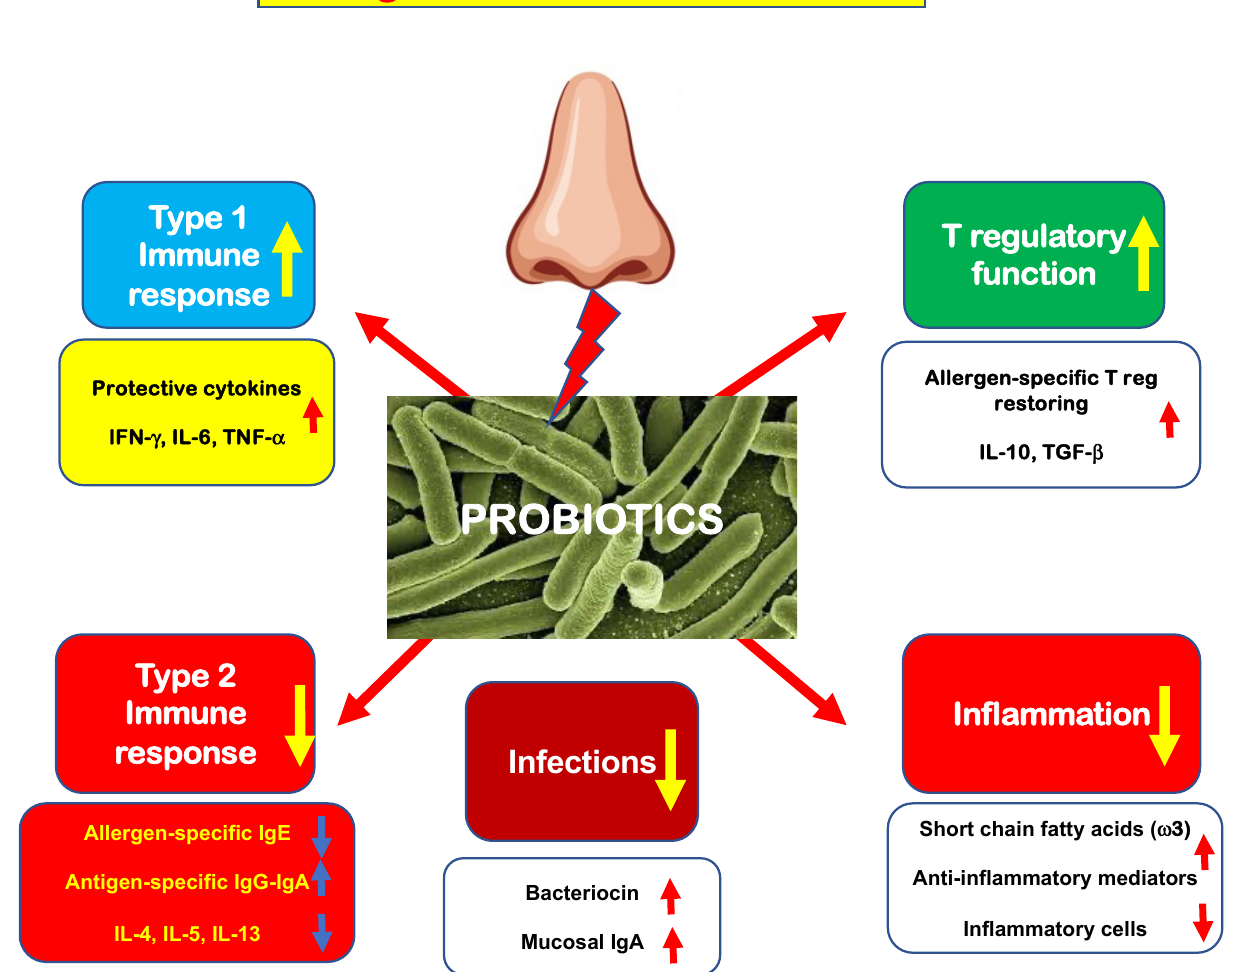
Figure 1. Schematic representation of the possible probiotic mechanisms of action in allergic rhinitis.